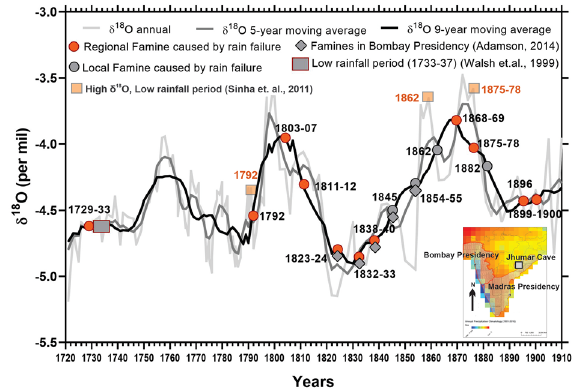
Figure 4. Relationship between long-term rainfall climatology and famines: Analysis of famine incidence and δ 18 O measurements in cave carbonates (also called speleothems); inset shows the location of the Jhumar Cave, Chhattisgarh, the only available long-term and high-resolution record of regional climatology 26,27 . Also see Fig. S5 and SI for details. Higher δ 18 O values indicate a drier period (also see SI section A) and lower values indicate wetter periods. Annual, 5-year and 9-year moving averages are plotted. There is evidence of quasi- multidecadal cyclicity (Fig. S5) in the δ 18 O data, indicating complex climatological controls (both from oceanic as well as land–atmosphere processes and feedbacks) on rainfall variability in the SARs of southern India in addition to the robust ENSO signal 28–30,45 . The cycles, however, are associated with famines, with a majority of the regional famines (in red) occur during the dry cycle (in some cases we note that the famines occur along the ascending limb of the annual data; this seeming offset is because of the memory effect of carbonate depositional process that lag rainfall 26,27,46 ). Also, each of the reported famines is associated with higher δ 18 O values (indicating rain deficient year). There is a lack of famines related information in 1720–1790 (documents present are